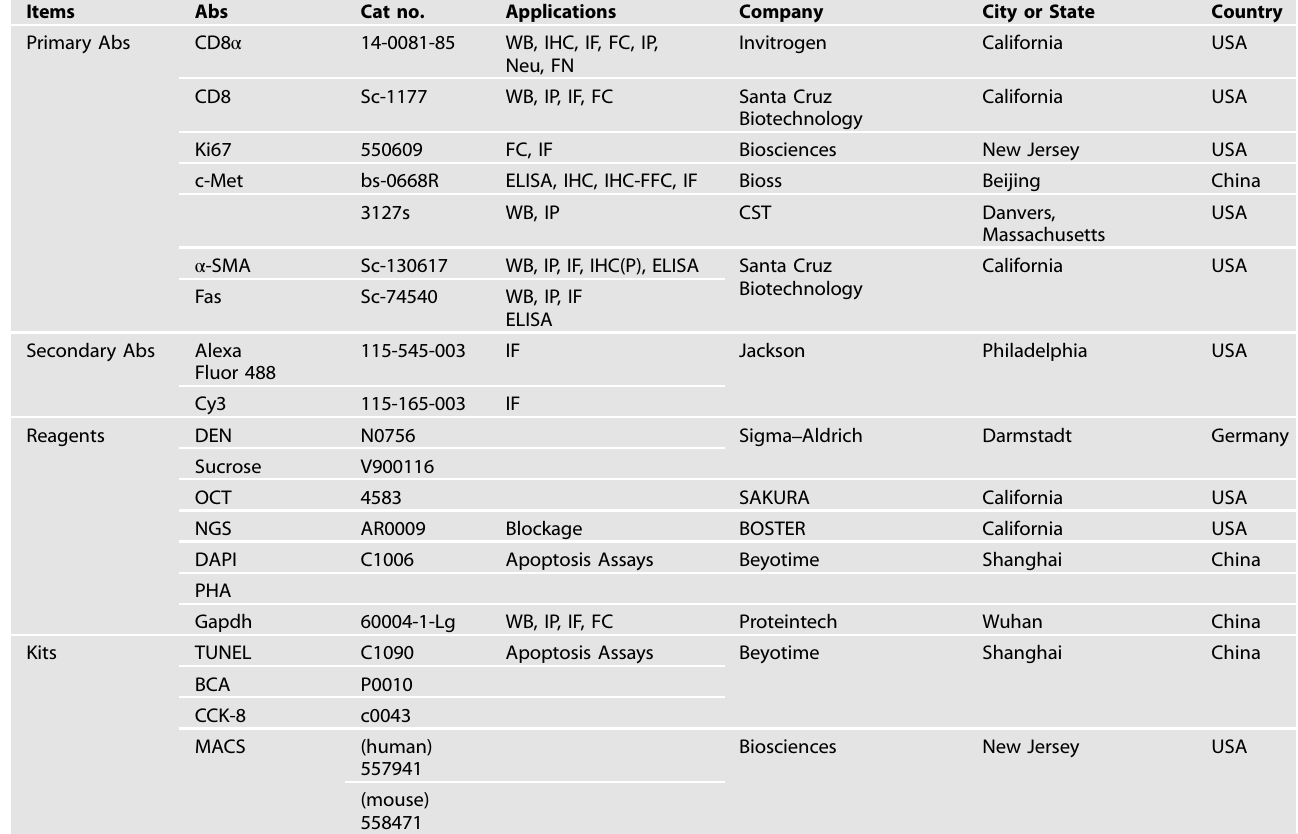
Table 1. Antibodies